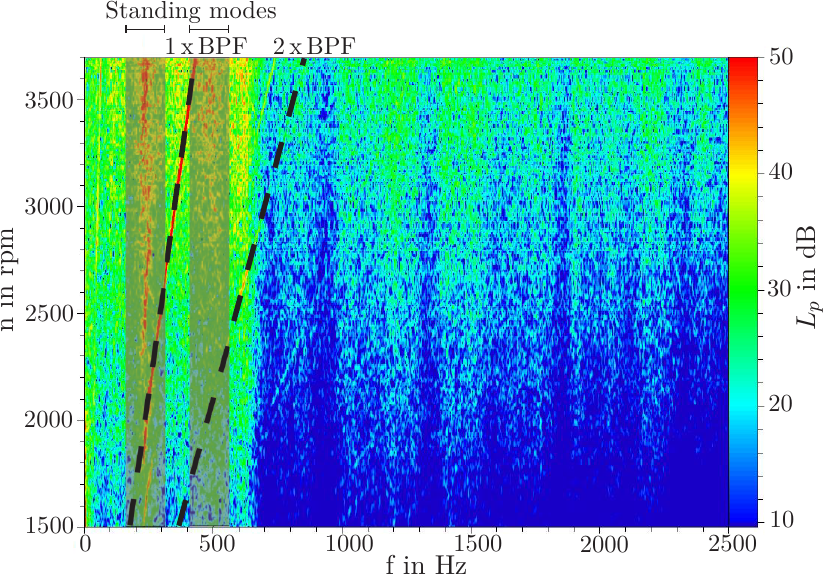
Figure 8. Total sound pressure L p , e level in comparison to the first and second BPF peak levels L p , e and L p , e extracted from the acoustic spectra averaged over measurement positions M1 to M11 for BPF 2 experiment (EXP) and simulation (SIM).